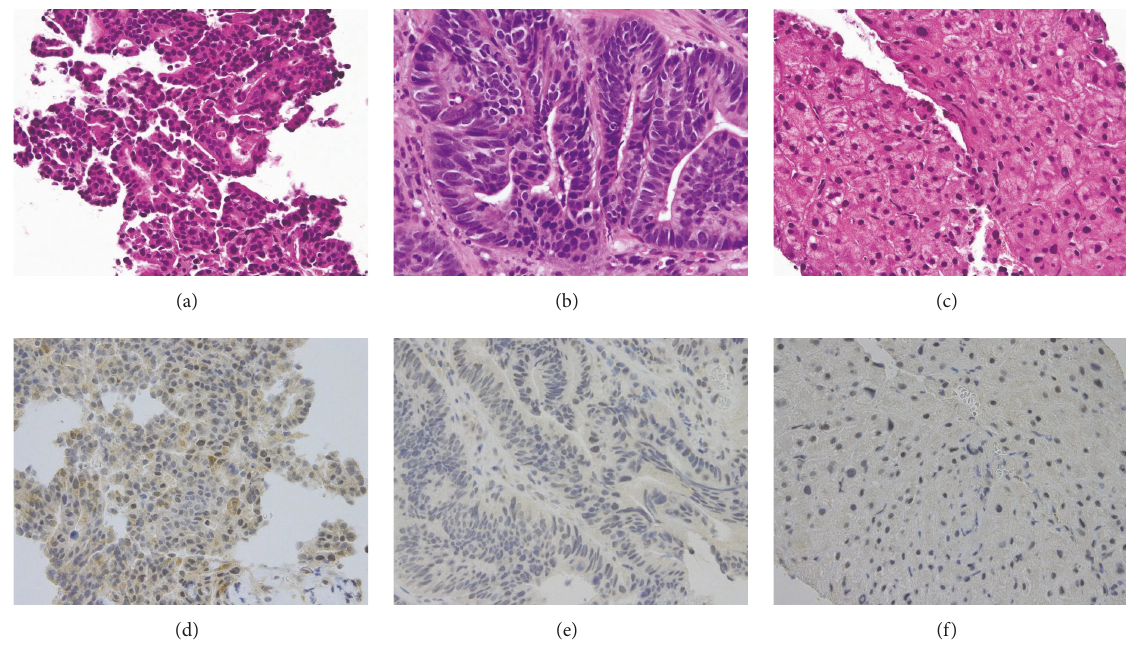
Figure 3: Histological examination of an ICC (a, d), gastric cancer (GC; (b, e)), and normal hepatocyte (c, f). Hematoxylin and eosin staining ( × 400) of an ICC (a), an adenocarcinoma suggesting GC (b), and normal hepatocyte (c). Immunohistochemical staining by anti-PTHrP antibody (H-137; Santa Cruz Biotechnology) in an ICC (d), GC (e), and normal hepatocyte (f).